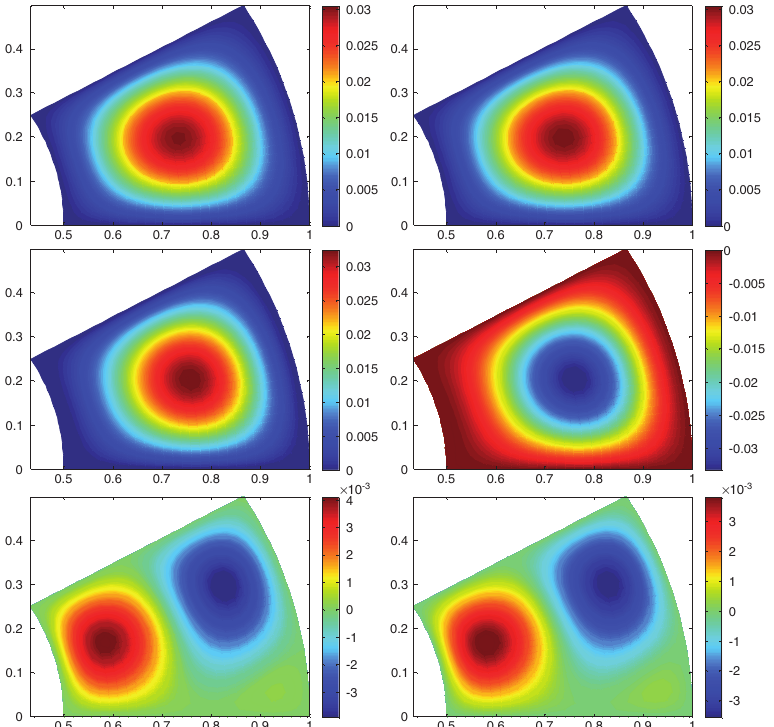
Figure 15 The first mode shapes of a fully clamped orthotropic FGM annular sector plate for different Winkler parameters: (A) 5e9, (B) 10e9, (C) 50e9, (D) 100e9, (E) 500e9 and (F) 1000e9 ( θ = 30 ° and n =